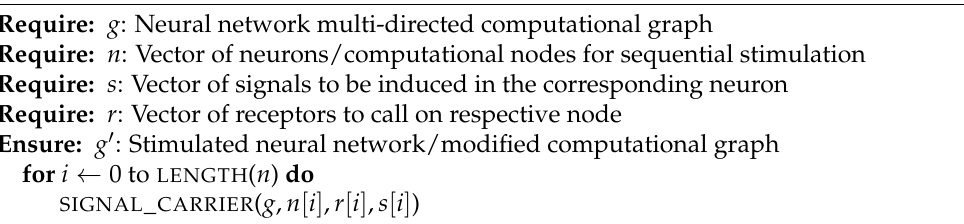
Algorithm 1 Neuronal-Firing, our exhaustive neuron stimulating, depth first, blocking, node-centric, graph/neuron stimulation